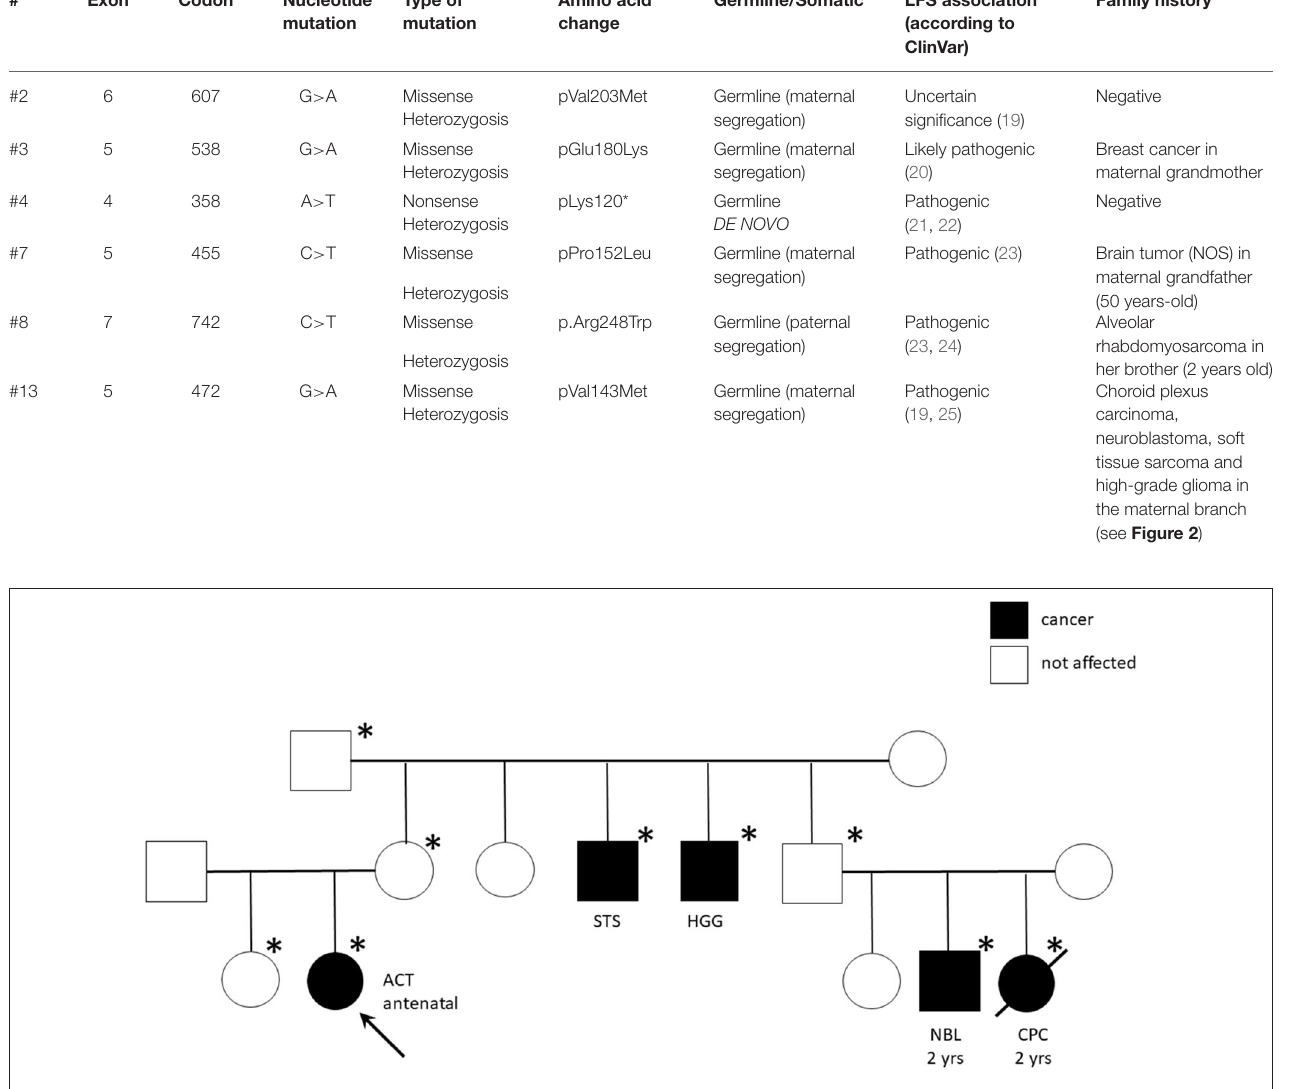
resection (17, 18, 36). In pediatric population, radiation